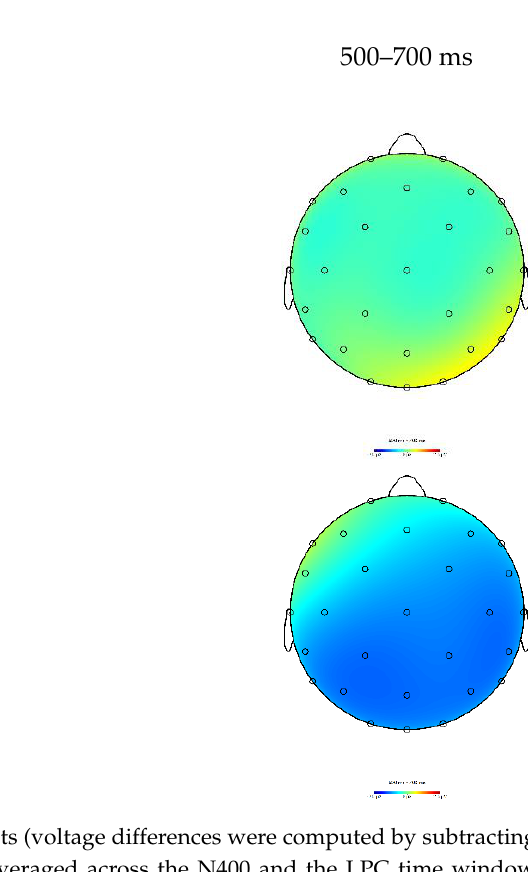
Figure 5. Grand average ERP waveforms for semantically unrelated (dotted lines) and semantically related words (solid lines) in Experiment 2. ERPs are plotted for nine equidistant representative electrodes within each region of interest. Negative voltage is plotted up. Onset of the Spanish word (i.e., the target) is indicated by the vertical calibration bar. Data are plotted from 100 ms prior to and 700 post stimulus onset.